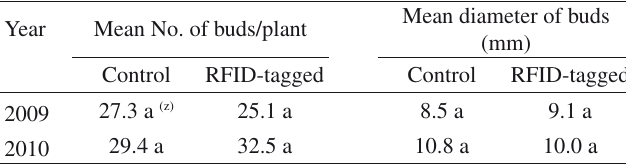
Table 3 - Mean number of buds for RFID-tagged basic grapevine recov- ered for grafting and mean diameter of buds